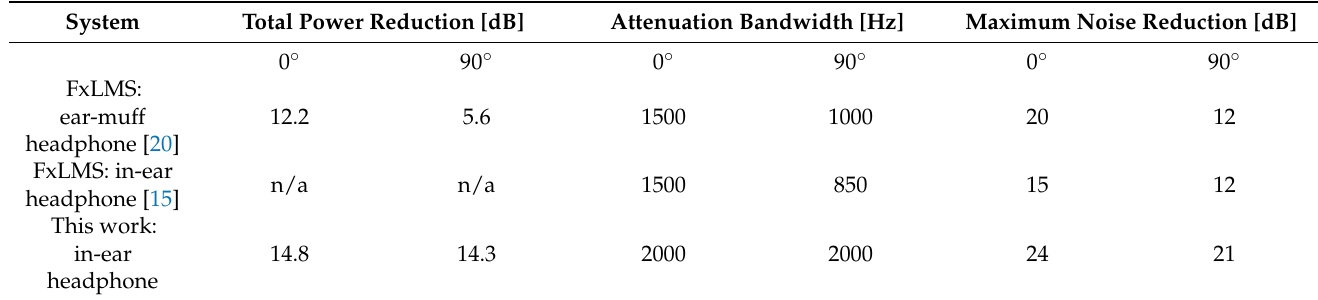
Table 3. Comparison of system